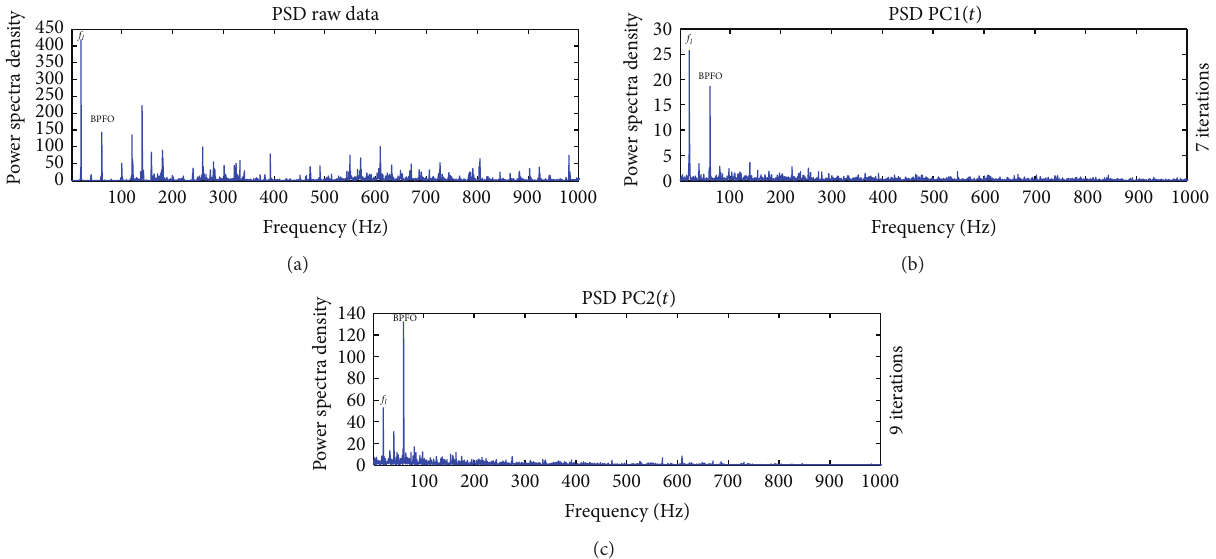
Figure 11: PSD of the raw signal and envelope spectra of the obtained components from ICD (bearing): (a) PSD raw data, (b) PC1( t ), and (c) PC2( t ).